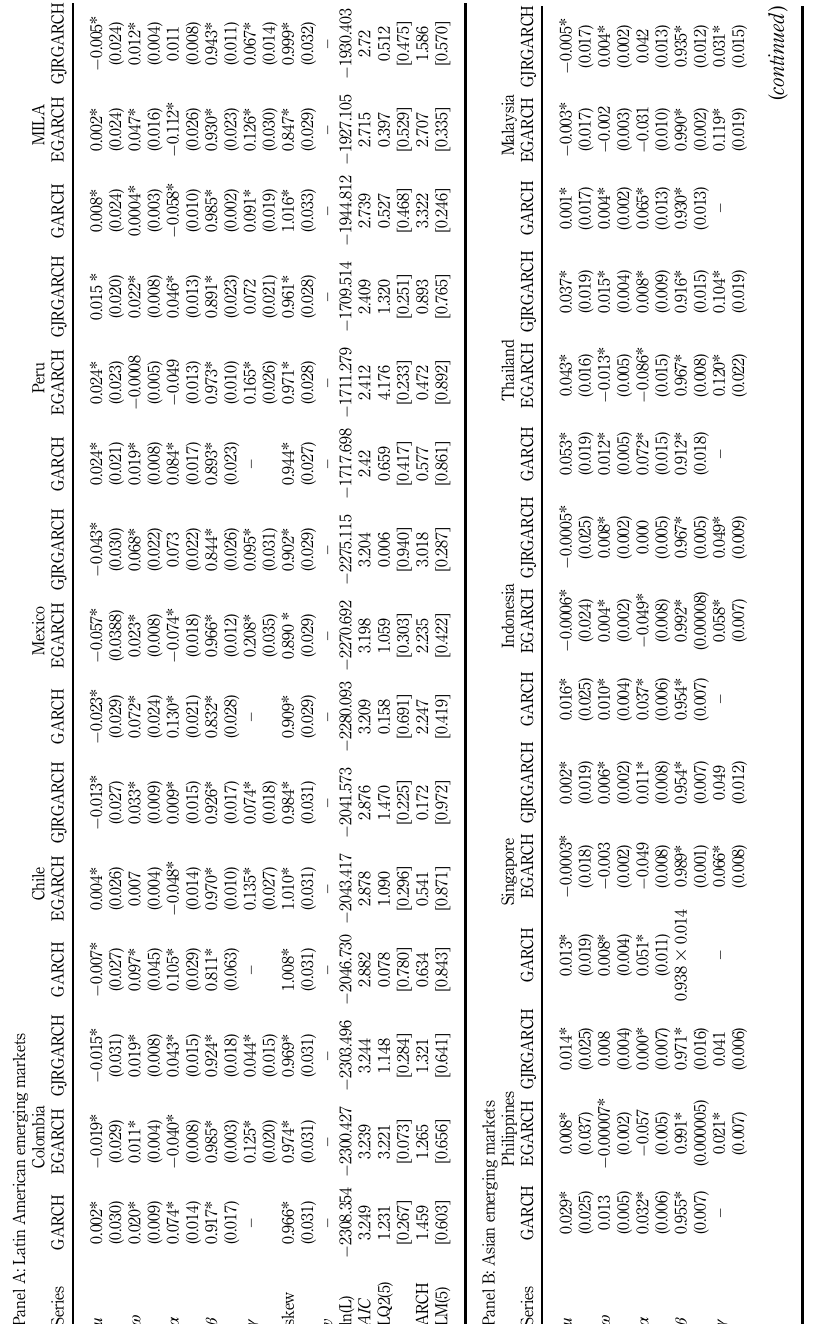
Table 3. Estimation results